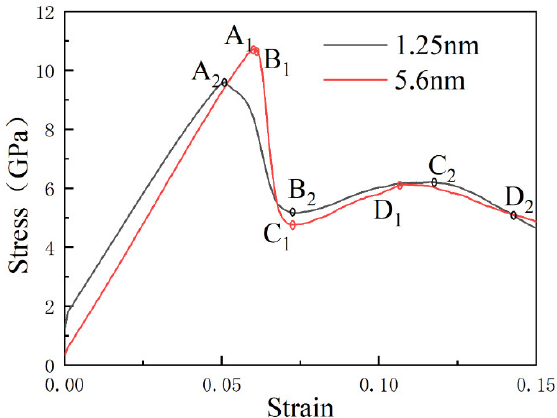
Figure 2. The stress–strain curves for compressed samples with h = 1.25 nm and h = 5.6 nm at 300 K. Points A 1 –D 1 and A 2 –D 2 are the four strain points of the stress-strain curve for the h = 5.6 nm and h = 1.25 nm samples respectively.